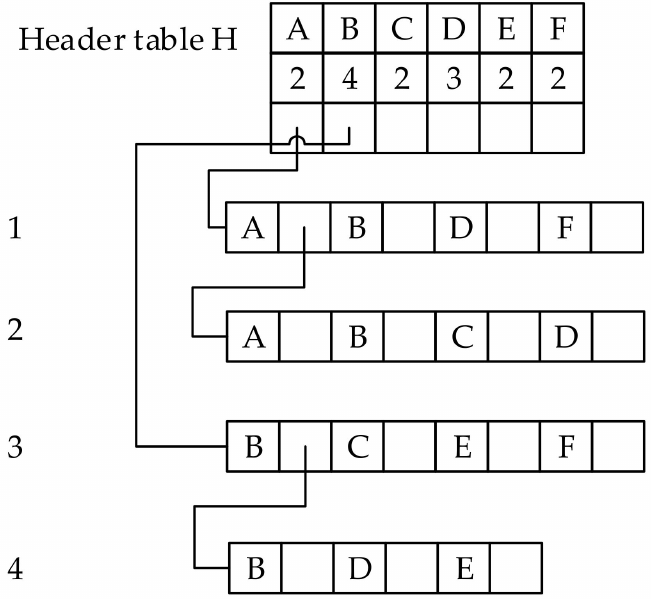
Figure 1. Header table H.